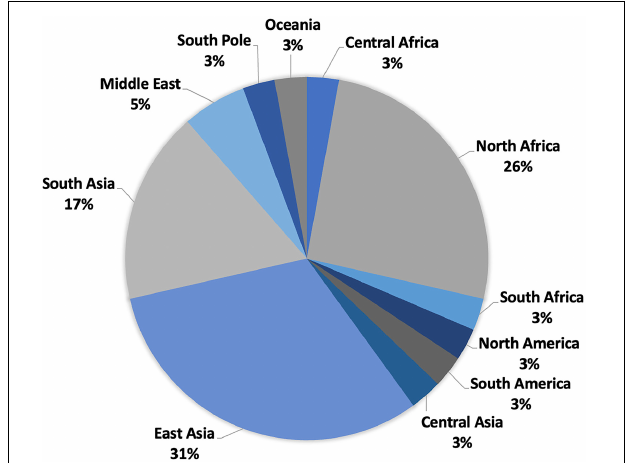
FIGURE 1 | Distribution of desert